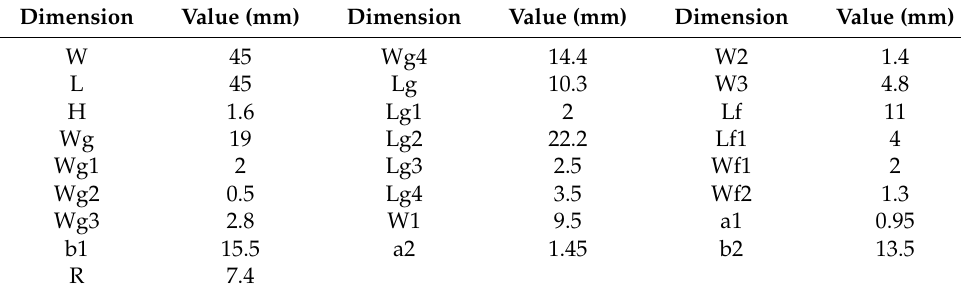
Figure 6. The schematic diagram of the proposed antenna: ( a ) top; ( b ) bottom. Table 1. Geometric parameters of the proposed MIMO antenna. Dimension